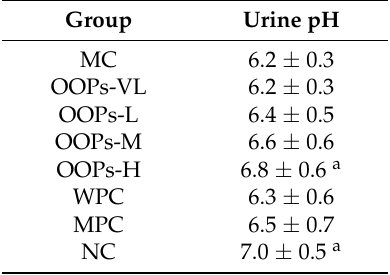
Table 1. Effect of OOPs treatment on the urine pH.